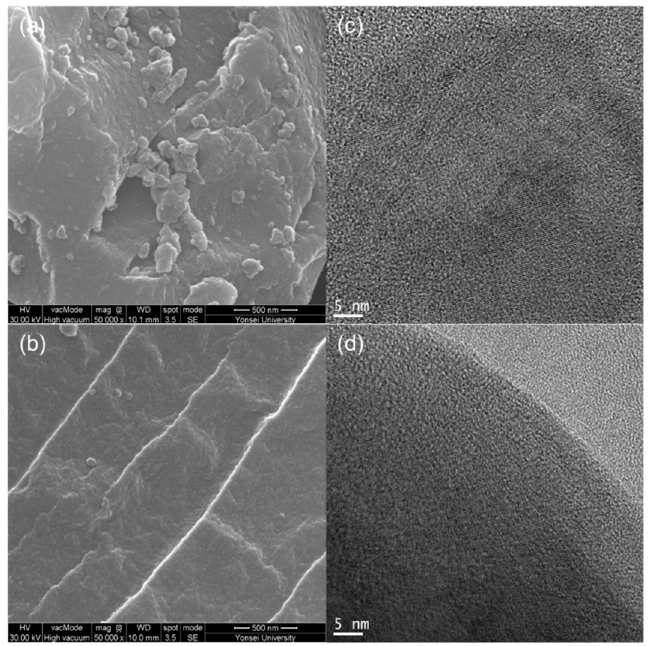
Figure 6. Morphology of NPSH. SEM images ( a , b ) and TEM images ( c , d ).